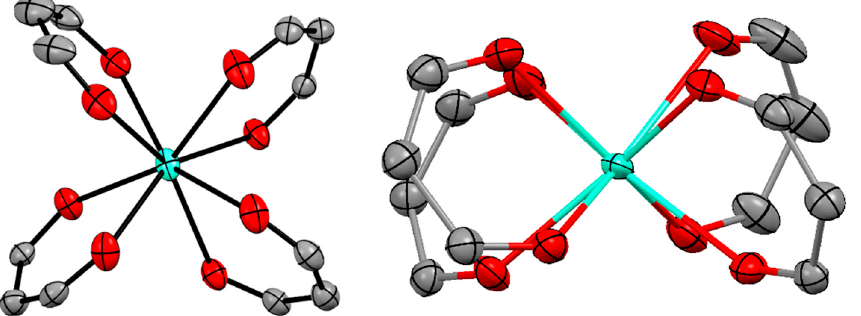
Figure 5. Top views of eight coordinate structures of europium (III) ion for 2a ( left ) and 2b ( right ). Aqua blue and red ellipsoids show Eu and O atoms, respectively.